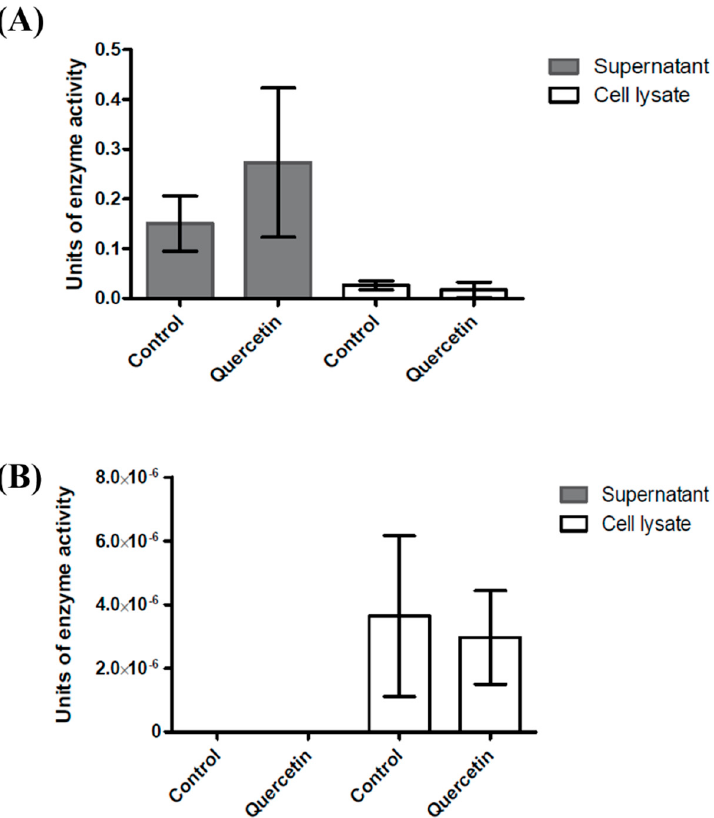
Figure 5. Quercetin-degrading enzyme activity as determined in the culture supernatants and cell lysates of B. glycinifermentans ( A ) and F. plautii ( B ). As can be observed in the figure, higher enzyme activity was observed in the culture supernatant of B. glycinifermentans when compared to the cell lysate ( A ). In contrast, minimal enzyme activity was observed in the cell lysate of F. plautii, while there was no quercetin degradation observed in its culture supernatant ( B ). The large standard deviations observed in these experiments are inherent to the nature of the study employed as previously reported [36]; however, the pattern observed is highly reproducible.